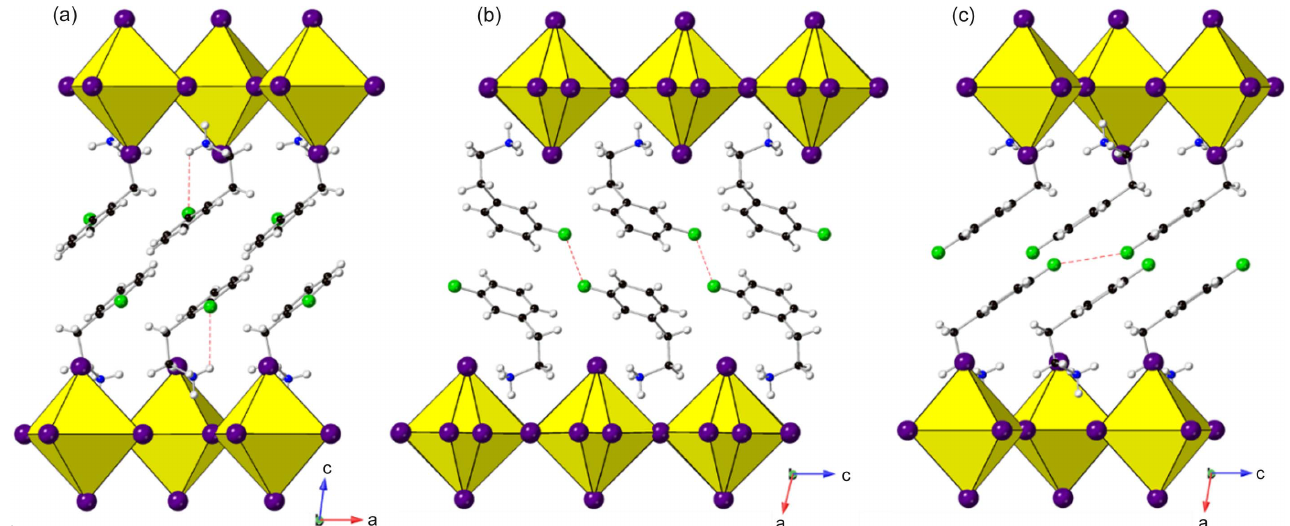
Figure 19 Structures of ( a ) o -, ( b ) m - and ( c ) p -positional isomers of [C 8 H 11 FN] 2 PbI 4 (1893383, 1893384 and 1488195, respectively). Intramolecular F (cid:8)(cid:8)(cid:8) H—N interactions in ( a ) and intermolecular F (cid:8)(cid:8)(cid:8) F interactions in ( b ) and ( c ) are shown by the dashed red lines. Note the presence of disorder in the I positions in ( b